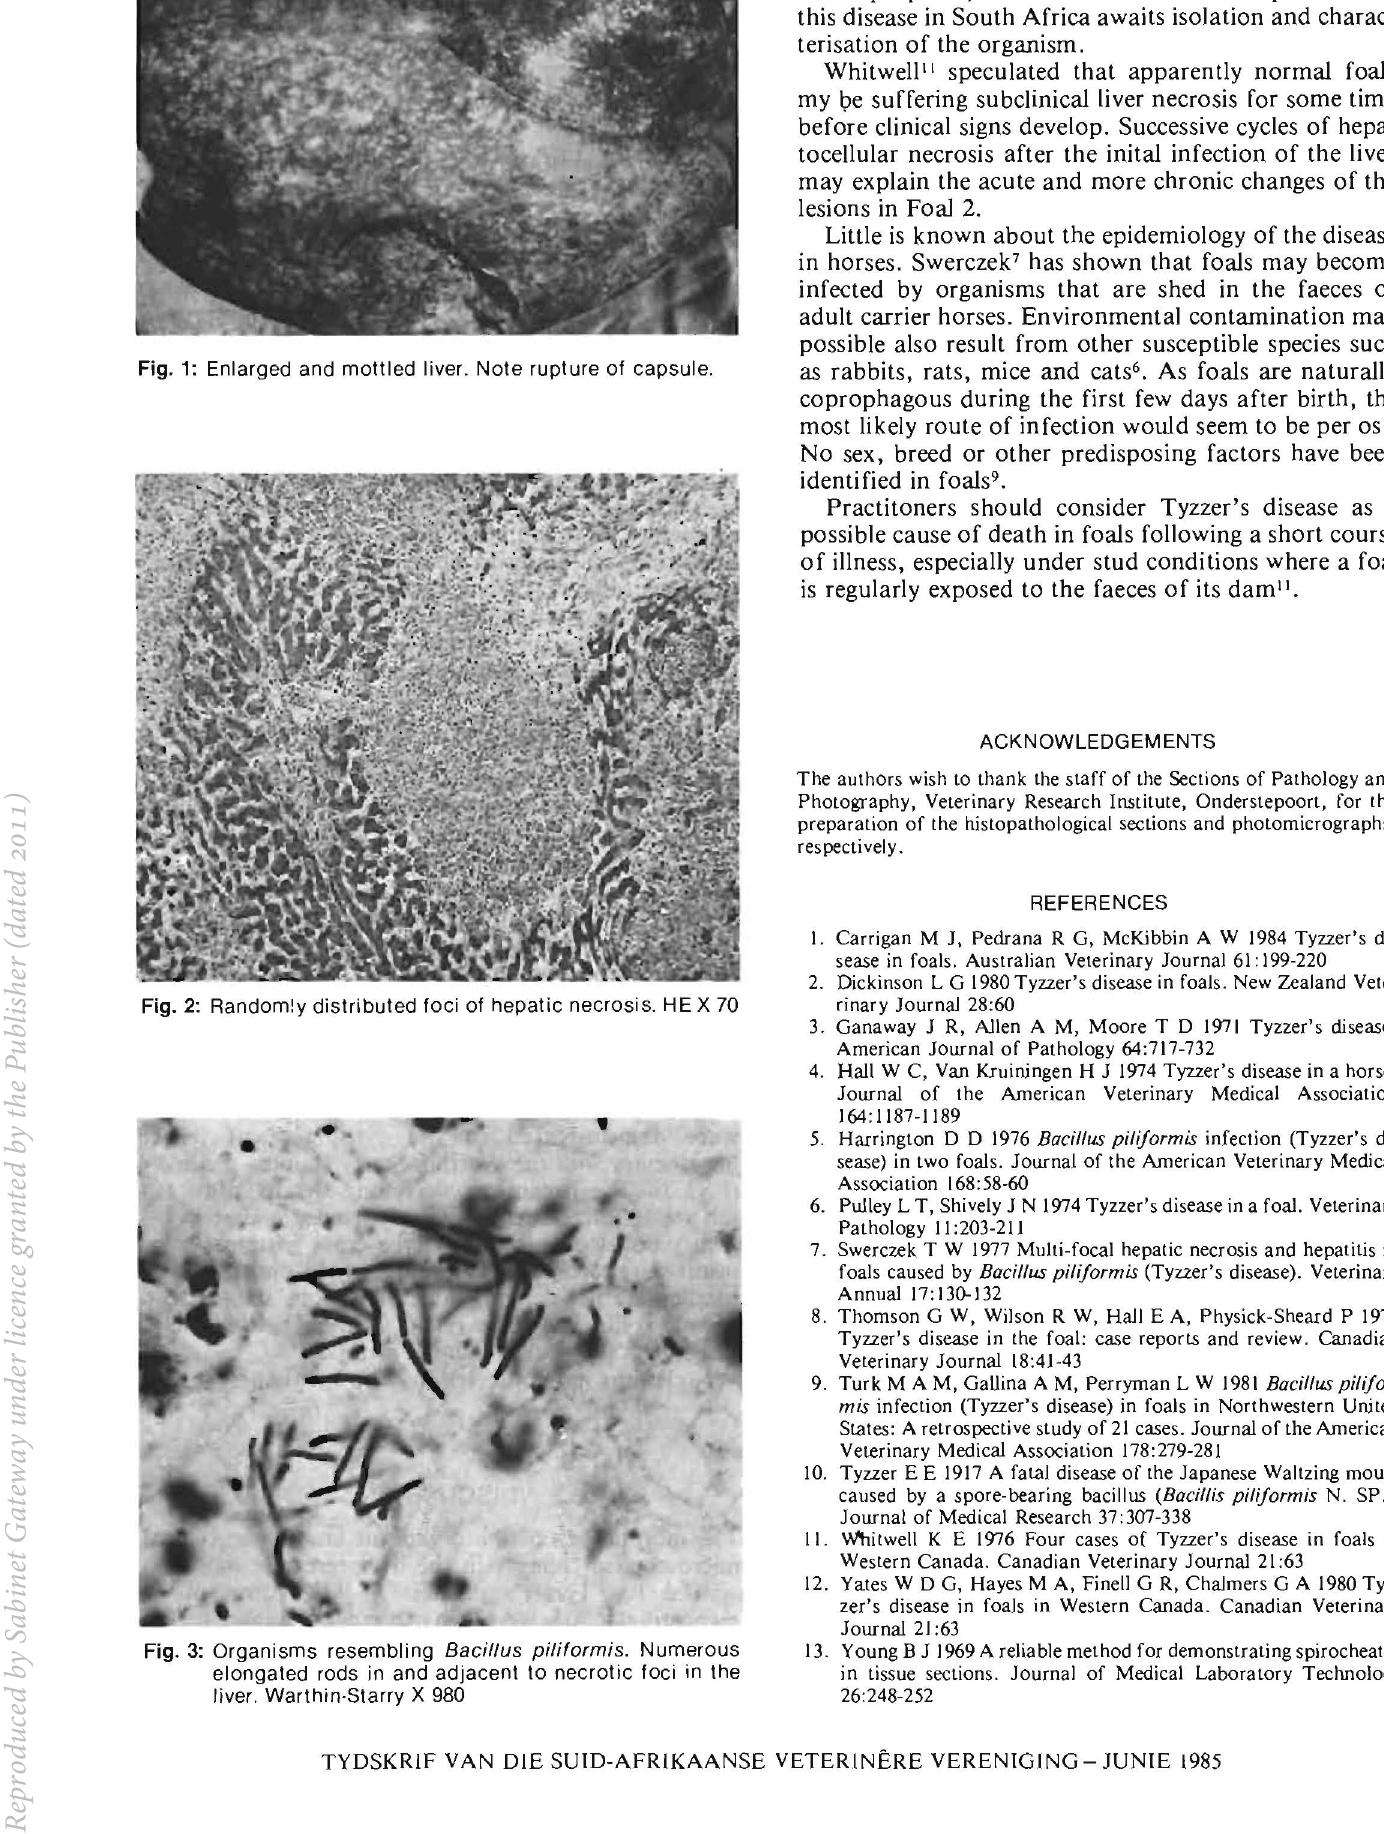
Fig. 3: Organisms resembling Bacillus piliformis. Numerous elongated rods in and adjacent to necrotic foci in